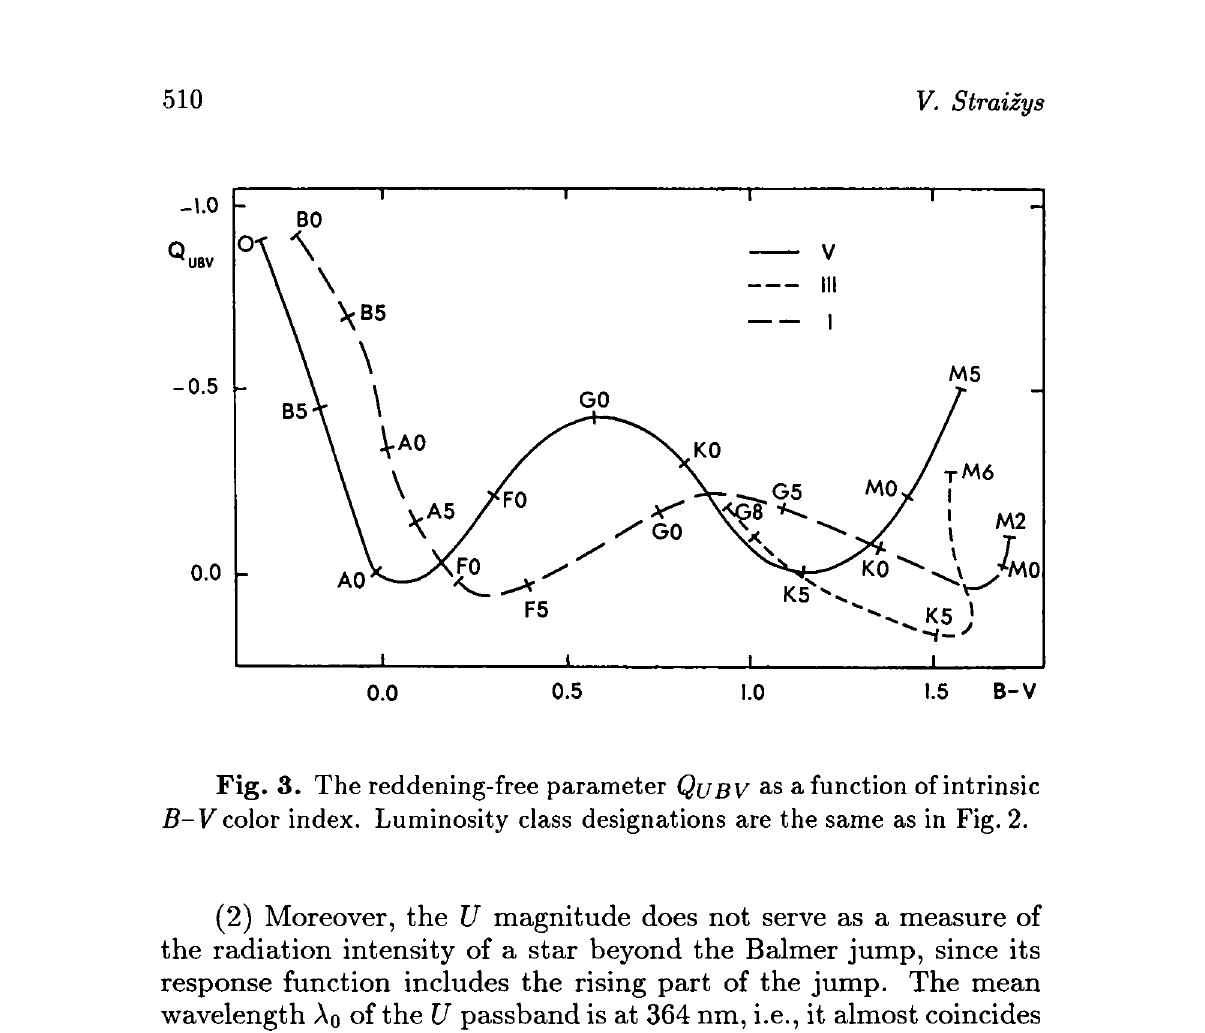
Fig. 3. The reddening-free parameter QuBV as a function of intrinsic B- V color index. Luminosity class designations are the same as in Fig.